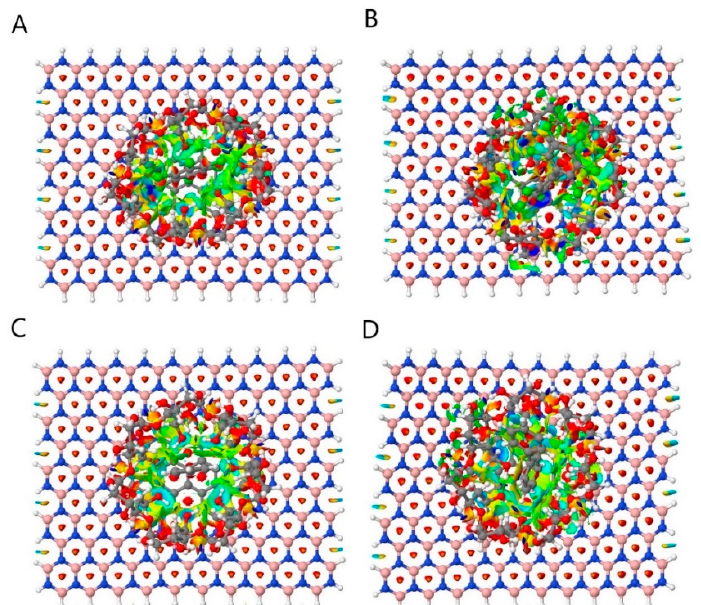
Figure 1. Non-covalent interaction between ( A ) hexachlorobenzene (cb), ( B ) decachlorobiphenyl (pcb), ( C ) benzene (b), and ( D ) biphenyl (bp) and carbon-doped hexagonal boron nitride (h-BN-CC2) decorated with beta-cyclodextrin (BCD).